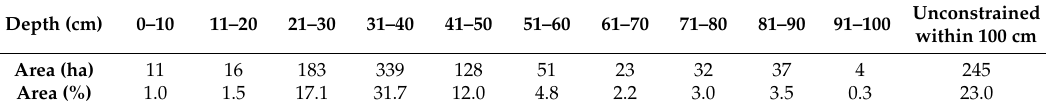
Figure 6. Digital soil map of the depth in which soil pH constraint ( > 9) is reached across the study area. Table 2. The area constrained at various depth intervals where pH > 9 is first observed.